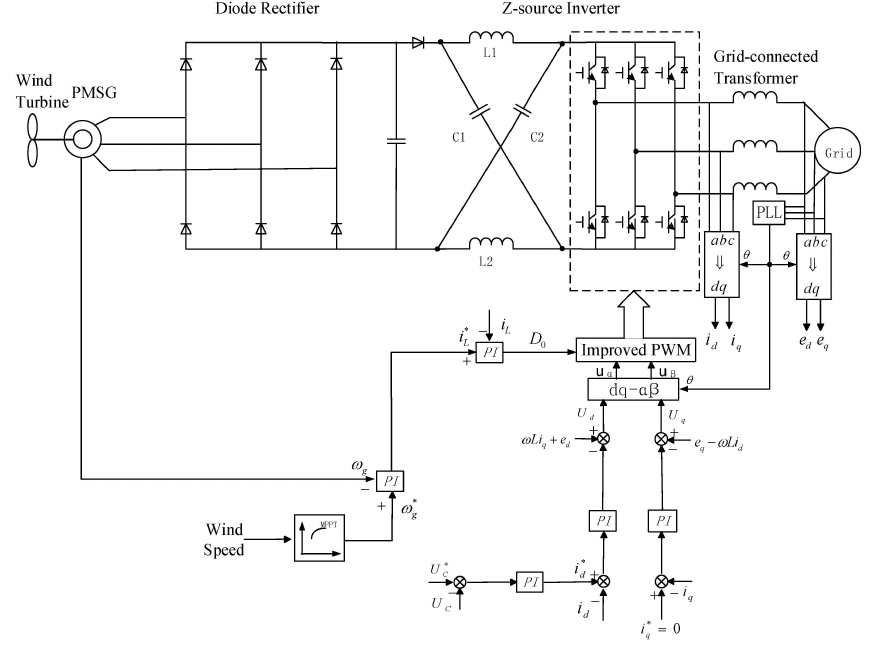
Figure 9. The control system of three-phase Z-source grid-connected